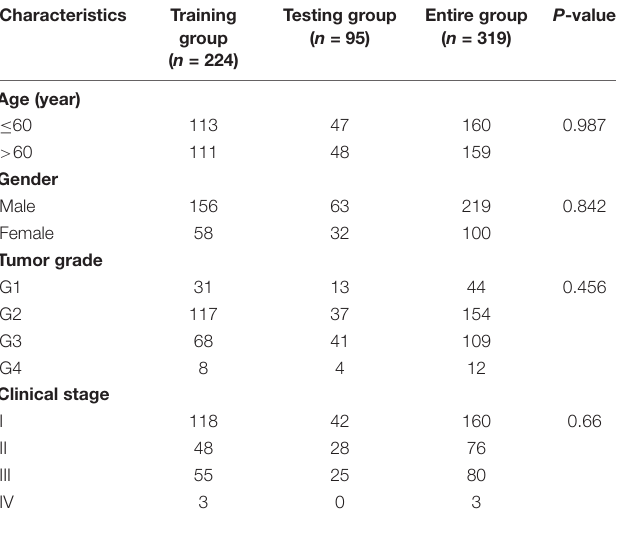
TABLE 1 | Characteristics of hepatocellular carcinoma patients from TCGA dataset.